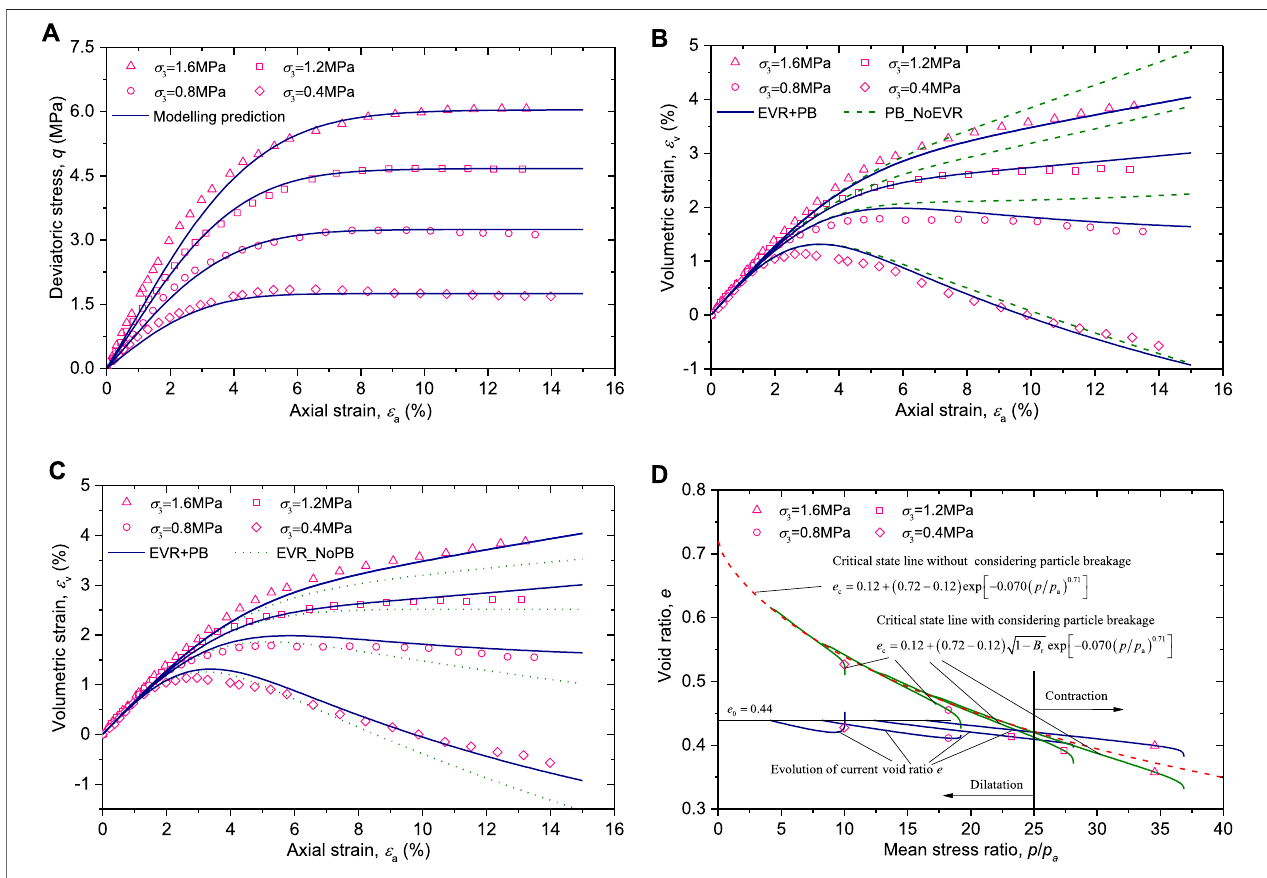
FIGURE 2 | Model predations and experimental results of the Wudongde rock-soil aggregate (test data were from [22]).